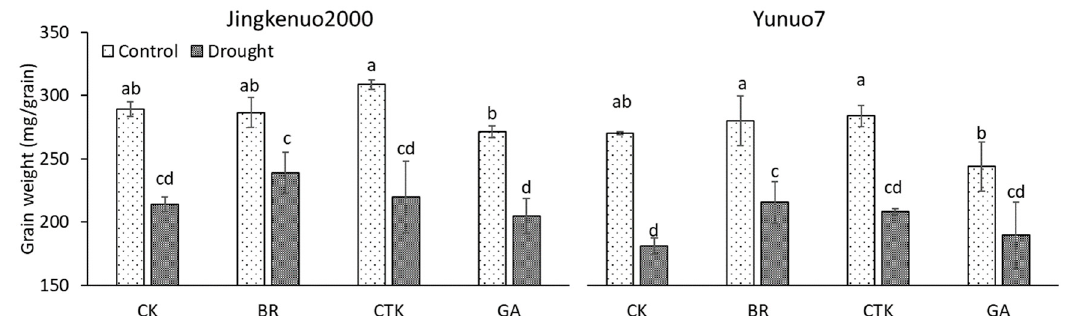
Figure 1. The grain weight with exogenous hormones under control and drought conditions in waxy maize. CK, water; CTK, cytokinin; BR, brassinolide; GA, gibberellic acid. Bars mean SE (n = 3). Different letters above the bars in each hybrid are significantly different at 5% probability level.